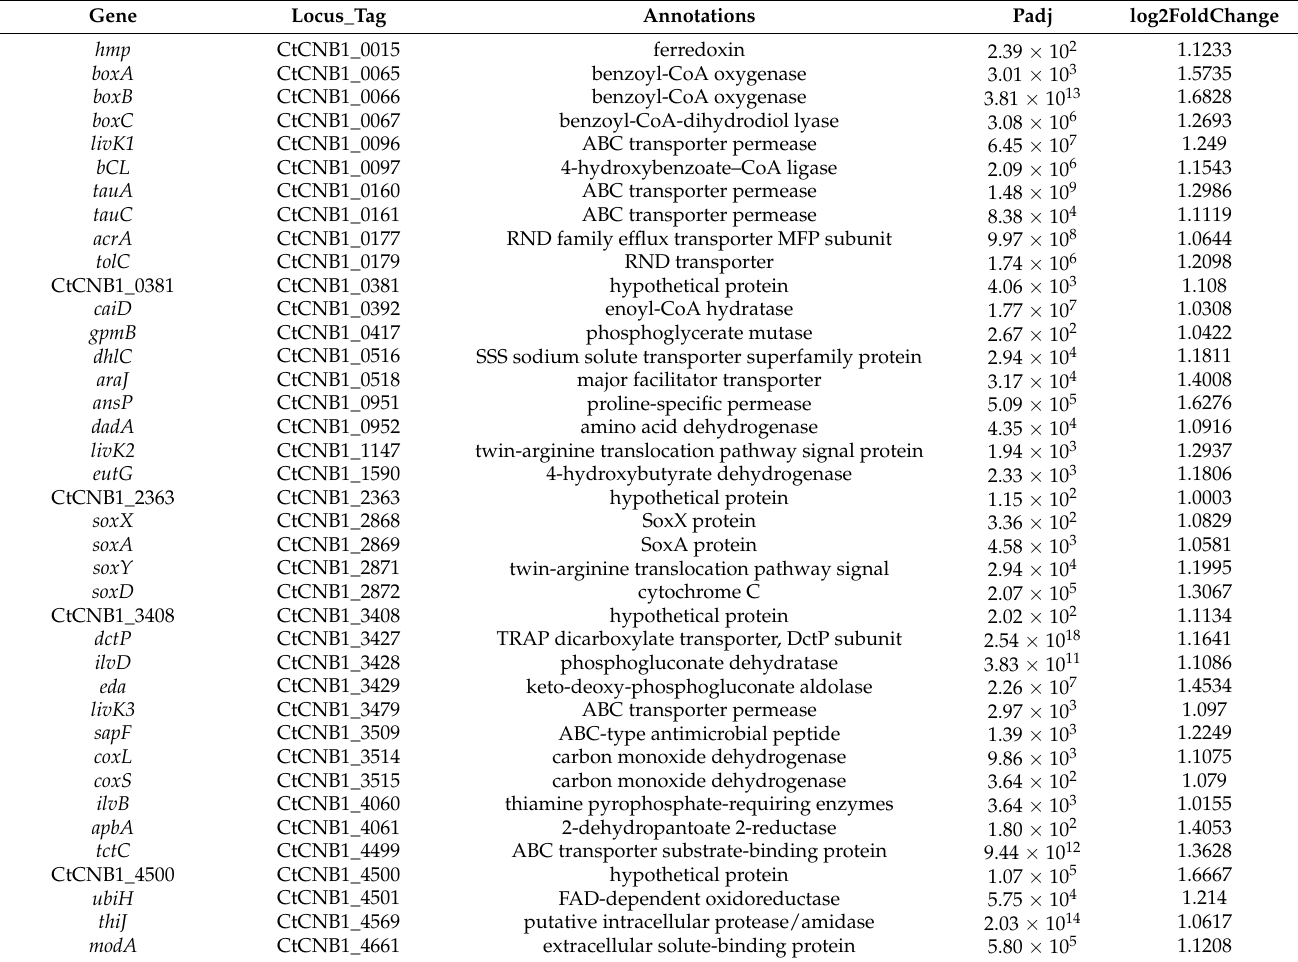
Table 2. Genes that show significant and >2-fold change at the transcriptional level in C. testosteroni strain CNB-1 ∆ flmD